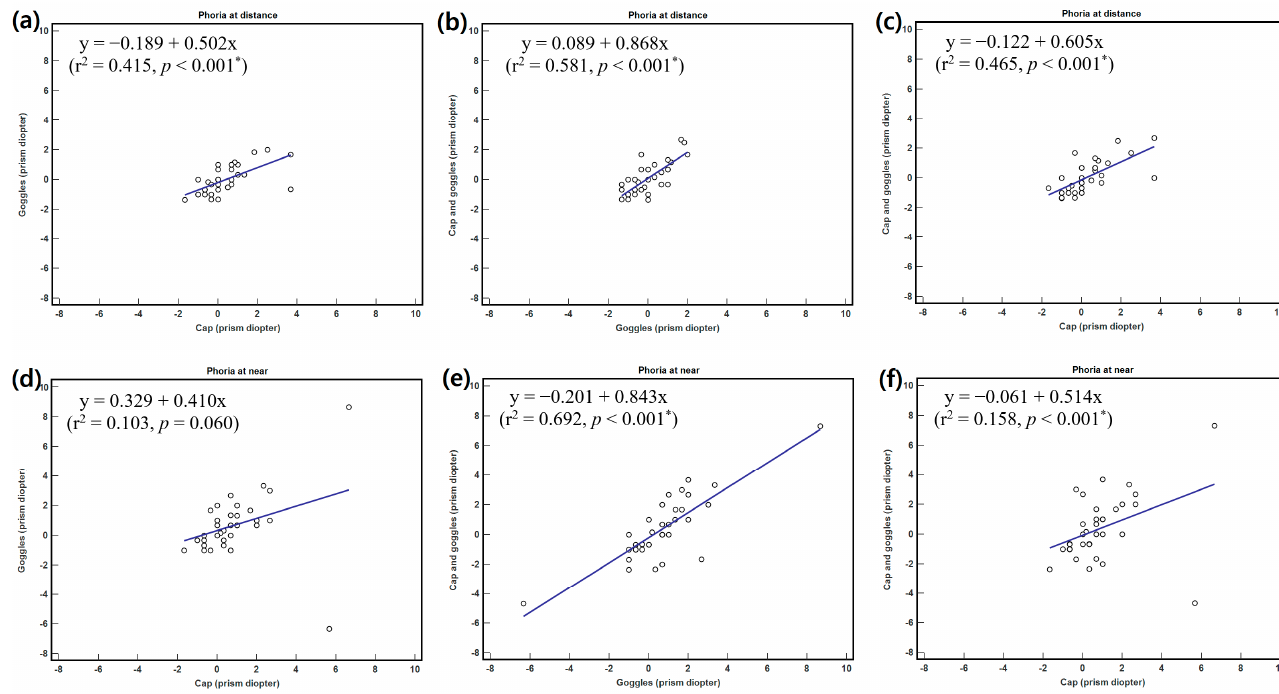
Figure 1. Regression analyses between a swimming cap, goggles, and both a cap and goggles for changes in phoria at distance and near. ( a ) Cap vs. goggles, ( b ) goggles vs. cap and goggles, ( c ) cap vs. cap and goggles at distance; ( d ) cap vs. goggles, ( e ) goggles vs. cap and goggles, and ( f ) cap vs. cap and goggles at near. R-squared (r 2 ) is the coefficient of determination. * p < 0.05 indicates a statistically significant finding.